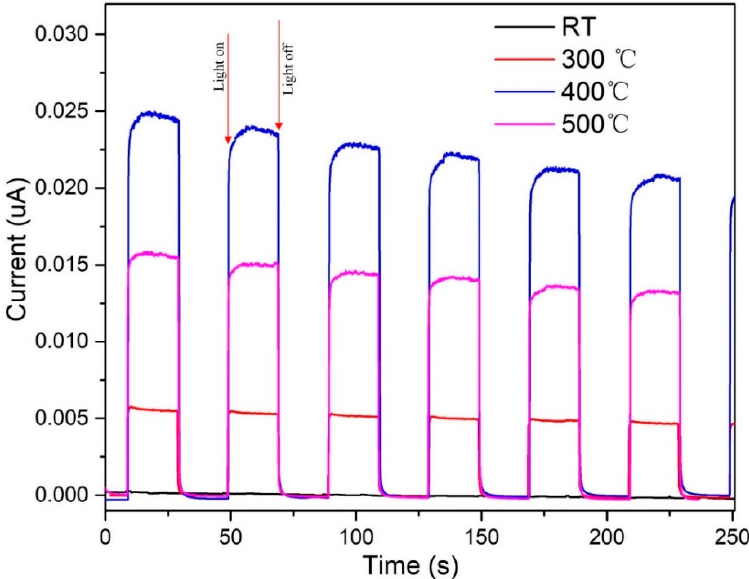
Figure 12. Transient photocurrents of the as-deposited hierarchical ZnO microspheres and hierarchical ZnO micro-spheres annealed at 300, 400, and 500 °C after exposure to UV light.